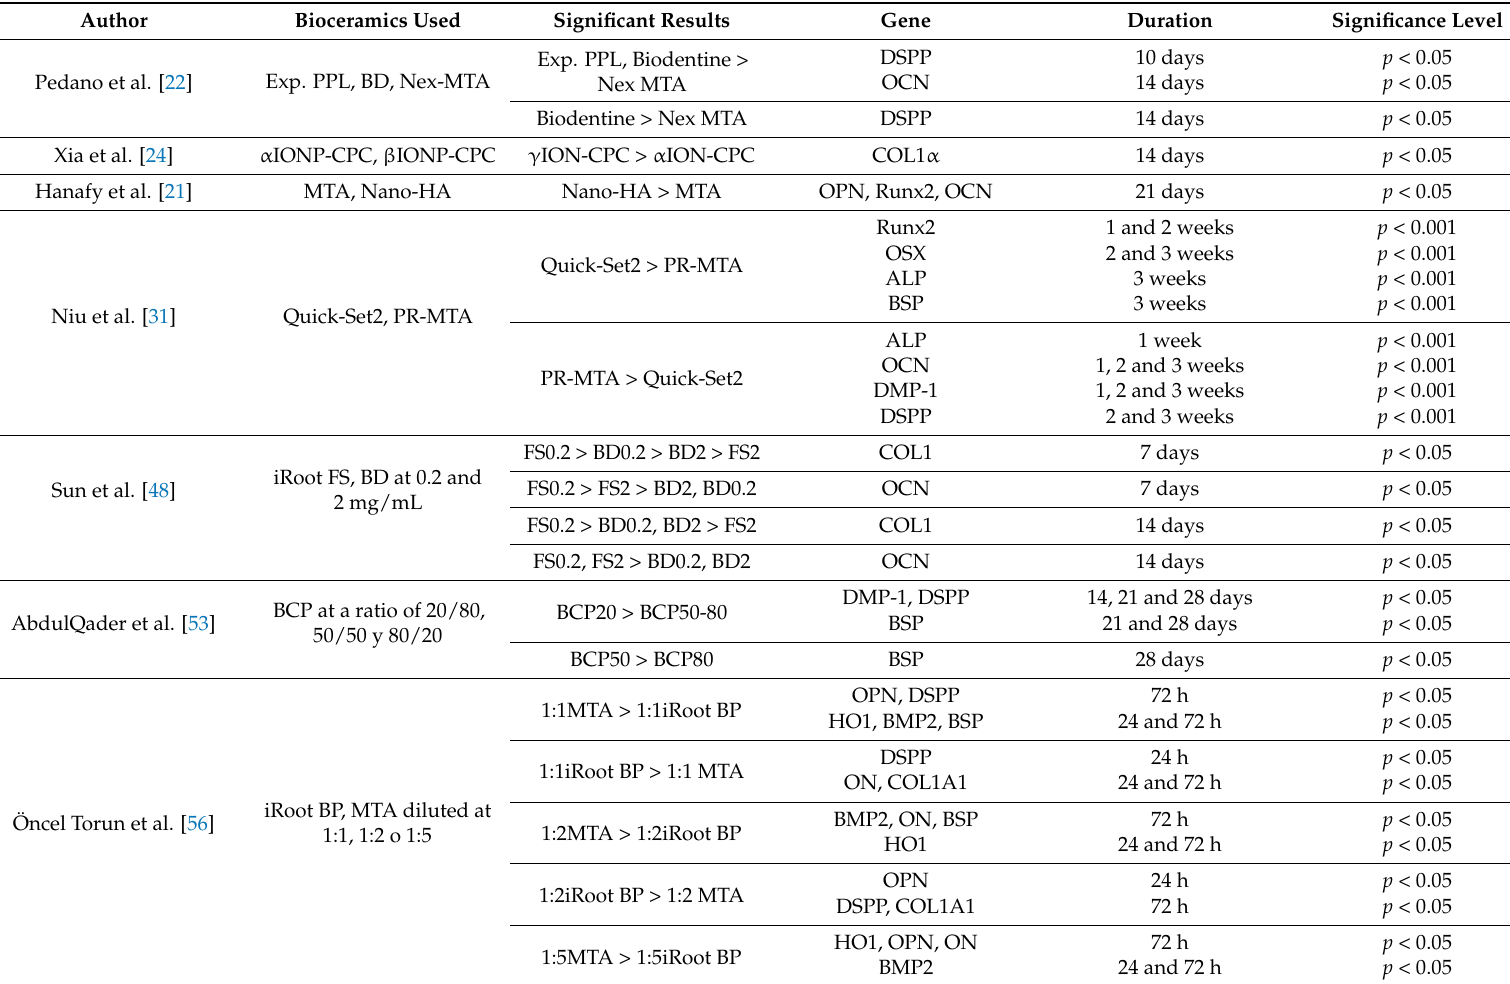
Table 7. Summary of the results of included studies showing significant differences between various bioceramic materials or different concentrations of the same bioceramic material for osteogenic, odontogenic and/or angiogenic gene